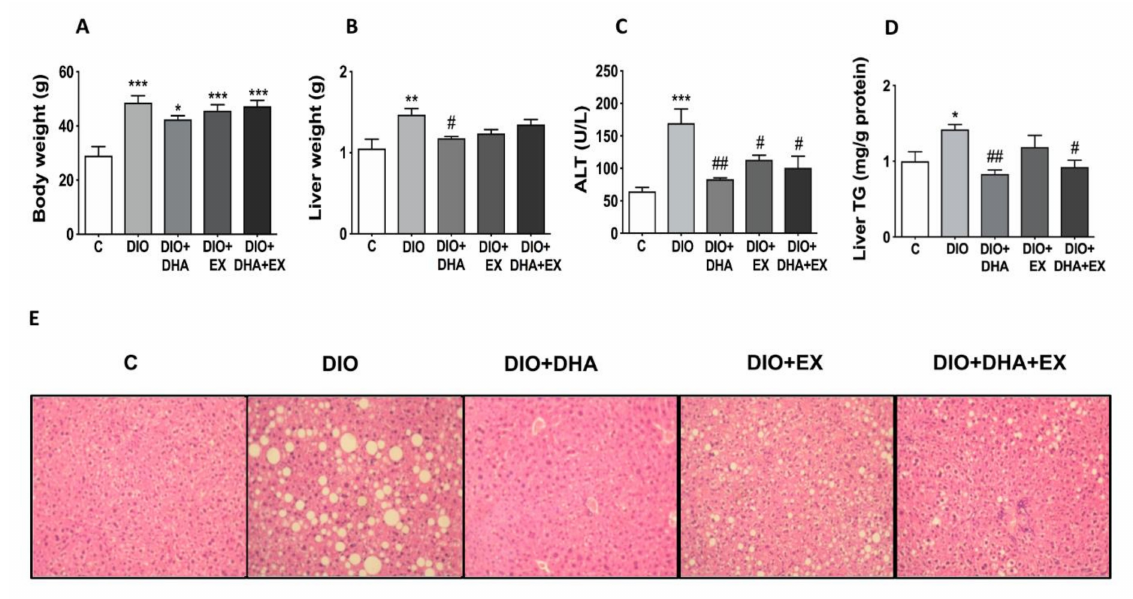
Figure 1. Effects of long-term DHA supplementation and/or aerobic exercise training on: ( A ) body weight, ( B ) liver weight, ( C ) serum ALT, ( D ) liver triglyceride (TG) content, and ( E ) liver morphology in 18-month-old diet-induced obese (DIO) mice. Data are mean ± SEM. n = 6–10 animals/group. * p < 0.05, ** p < 0.01, *** p < 0.001 vs. C group. # p < 0.05, ## p < 0.01 vs. DIO